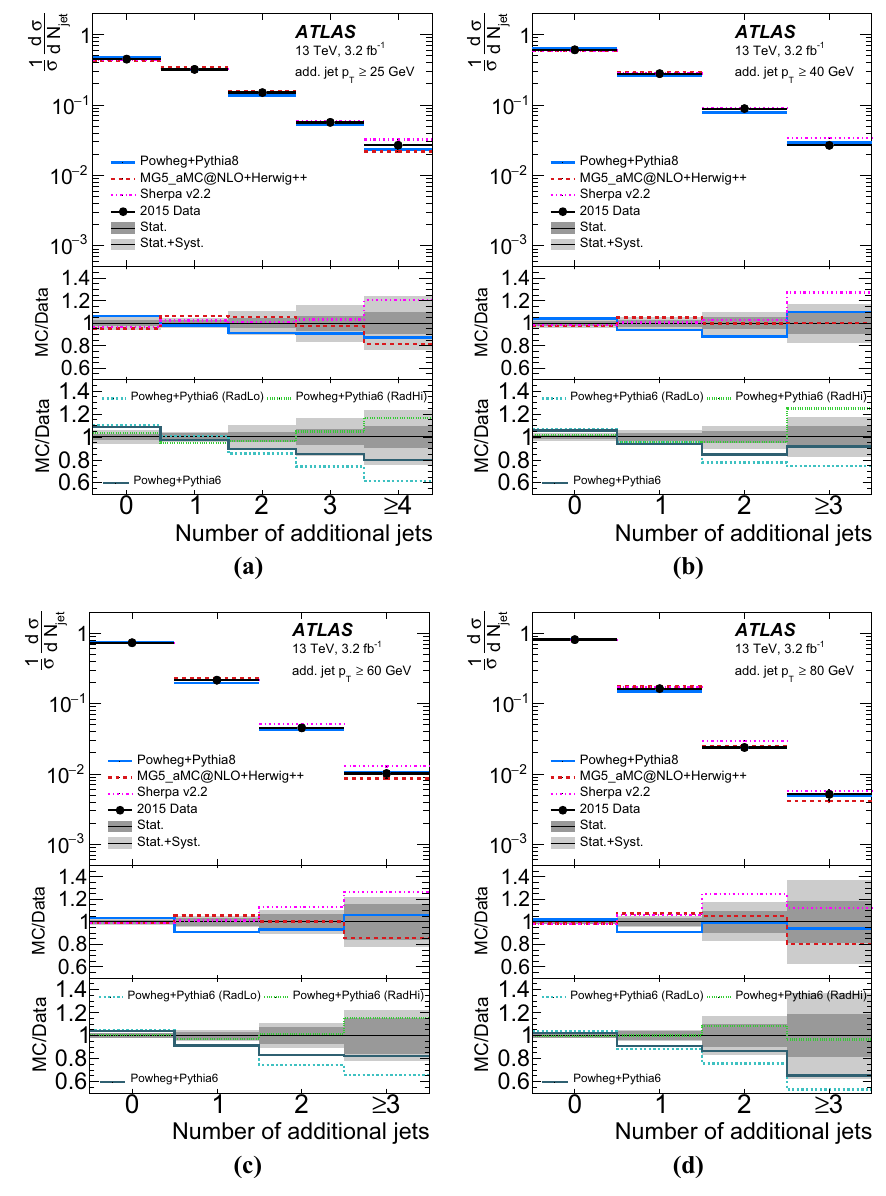
Fig. 4 Unfolded jet multiplicity distribution for different p T thresholds of the additional jets, for a additional jet p T > 25 GeV, b additional jet p T > 40 GeV, c additional jet p T > 60 GeV, and d additional jet p T > 80 GeV. Comparison to different MC predictions is shown for these distribution in first panel . The middle and bottom panels show the ratios of different MC predictions of the normalised cross-section to the measurement and the ratios of P owheg+ P ythia6 predictions with variation of the QCD radiation to the measurement, respectively. The shaded regions show the statistical uncertainty ( dark grey ) and total uncertainty ( light grey